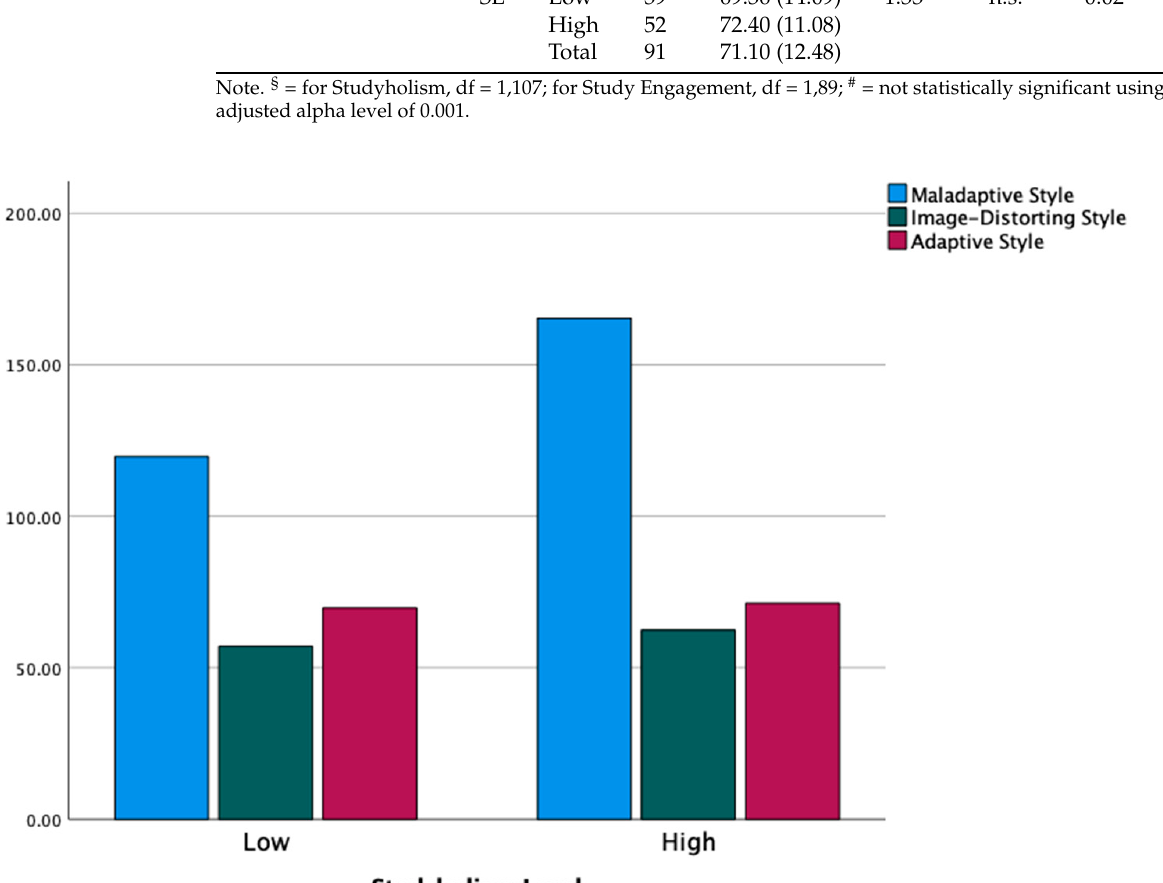
Figure 4. Mean levels of the three defense styles by low and high Study Engagement. 3.4. Defense Mechanisms as Predictors of High Studyholism We ran four binary logistic regressions with the single defense mechanisms included in the models accordingly to their inclusion in the maladaptive, image-distorting, adap- tive, or any factor. The model with the 11 maladaptive defense mechanisms is statistically significant (LR Test = χ 2 (11) = 92.77, p < 0.001) and explains a large variance in the probability of being “diagnosed” as having high Studyholism: Nagelkerke’s R = 0.874. In fact, using the 11 defense mechanisms, the percentage of students properly classified as having high and low Studyholism changes from 78.4% (baseline model) to 95.5%. Regarding the statisti- cally significant (positive) predictors, they are regression (OR = 2.68 (CI95% 1.31–5.46); p